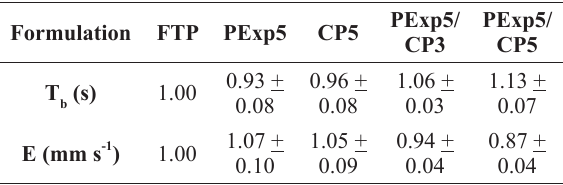
), and Erosion Rate b